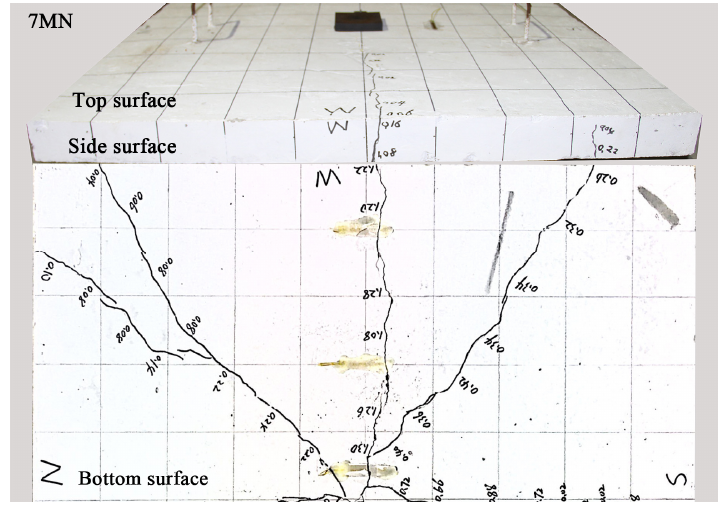
Figure 10. Radial cracks extending from the bottom to the